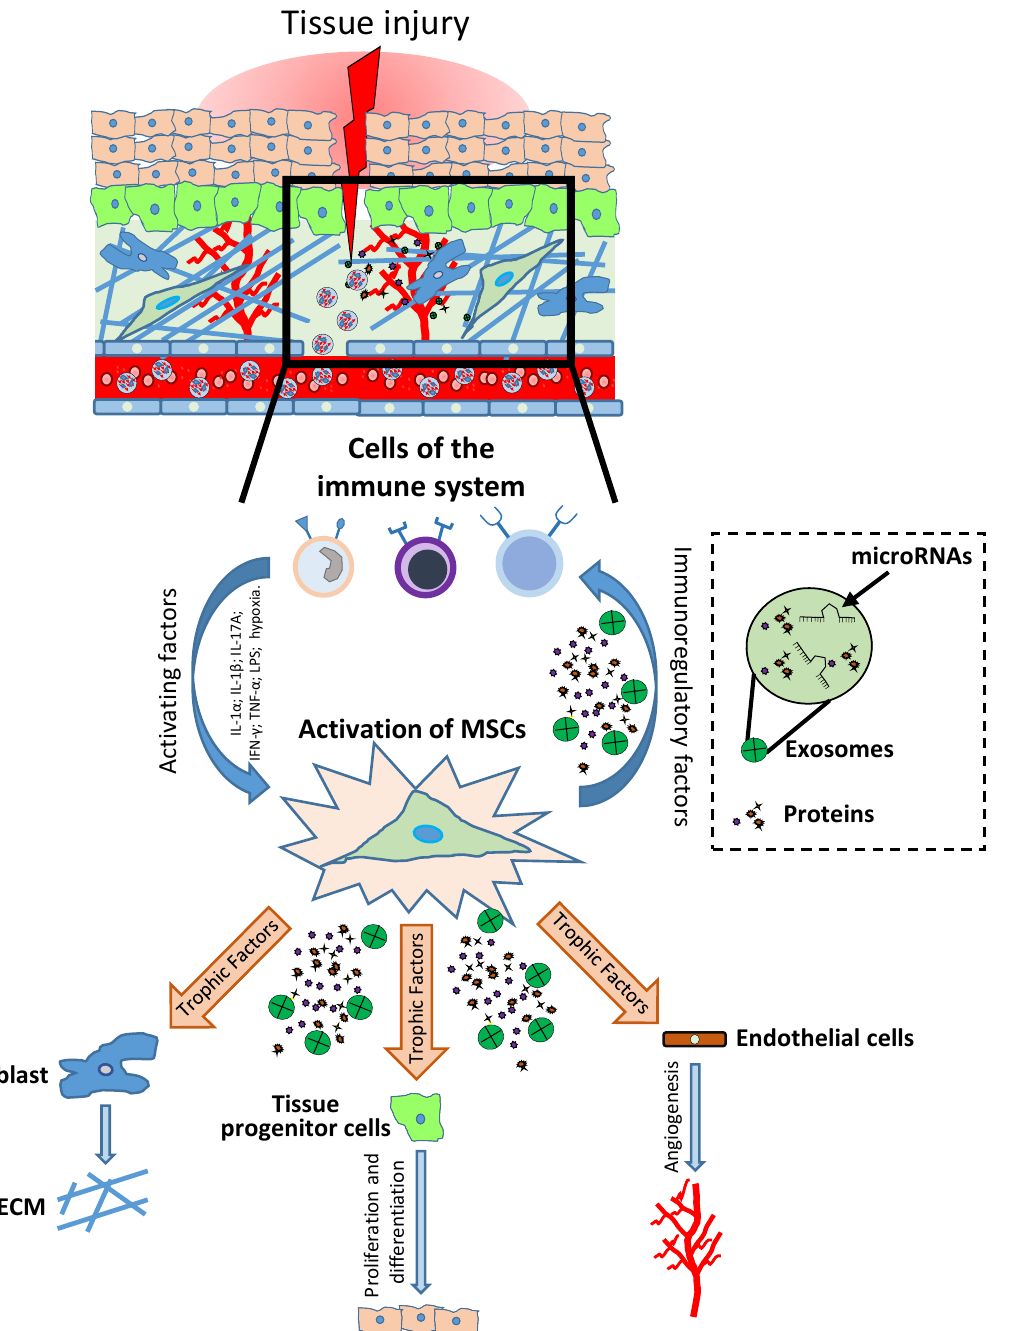
Figure 1. Role of mesenchymal stromal/stem cells (MSCs) in tissue injury and repair. After injury, the damaged tissue activates MSCs through different inflammatory signals (IL-1β, IFN-γ, TNF-α, LPS; hypoxia). MSC activation leads to coordination of the microenvironment by both the production of immunomodulatory factors (to modulate the progression of inflammation) and the production of growth factors which subsequently stimulate endothelial cells, fibroblasts cells and tissue progenitor cells. The physiological and orderly action of these factors allows tissue repair through angiogenesis, remodeling of the extracellular matrix (ECM) and functional tissue restoration through tissue progenitor cells differentiation.